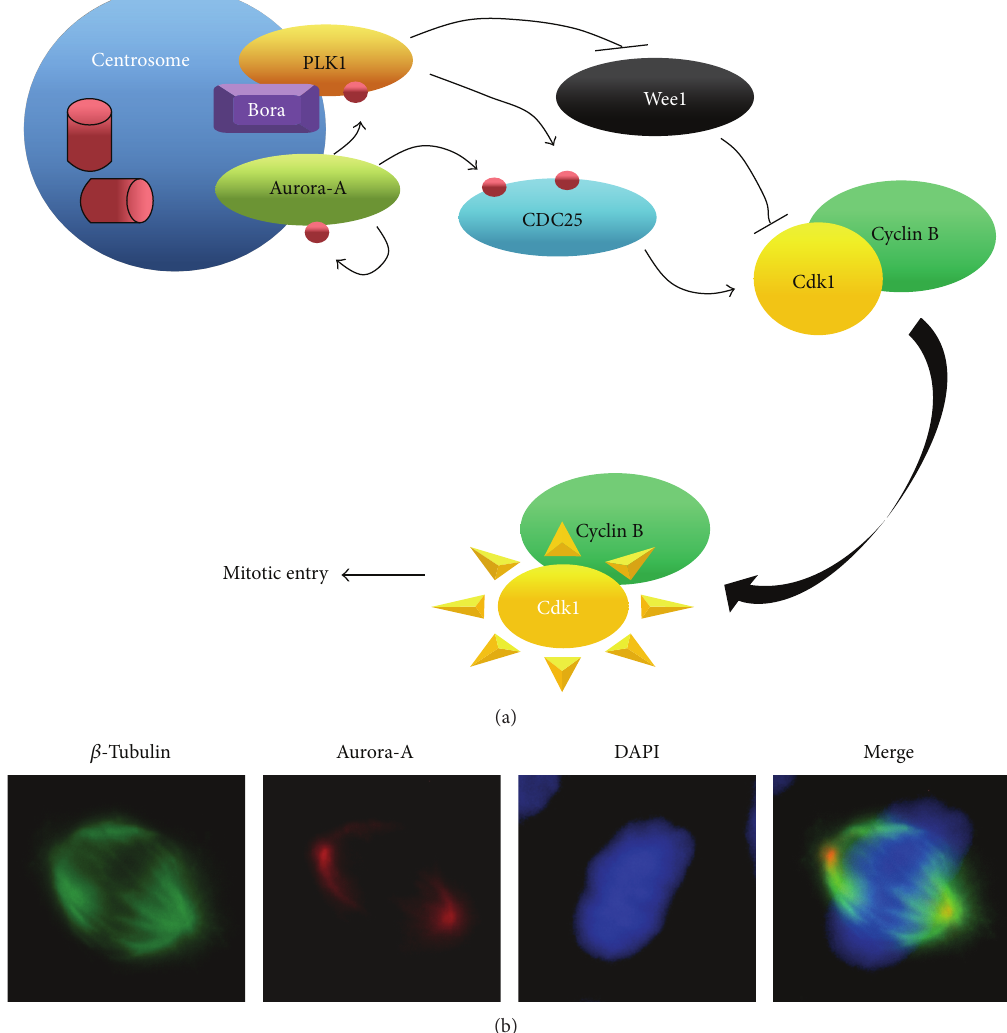
Figure 2: (a) Schematic representation of the pathway induced by Aurora-A to activate the CDK1/cyclin B complex allowing the transition of the cell from the G2 to the M phase. Aurora-A in association with Bora phosphorylates the PLK1. Both Aurora-A and PLK1 phosphorylate CDC25B (cell division cycle 25 B) allowing cyclin dependent kinase 1(CDK1)/cyclin B complex activation and thus promoting mitotic entry. PLK1 facilitates this process also by inhibiting the CDK1 inhibitor WEE1. Inactivation of Aurora-A or Plk1 individually shows no significant effect on Cdk1 activation and entry to mitosis, while their simultaneous inactivation produces a marked delay in both Cdk1 activation and mitoticentry,suggestingthatthetwokinaseshaveredundantfunctions.(b)ImmunofluorescenceshowingAurora-Alocalizationatthespindle pole of an anaplastic thyroid cancer cell in